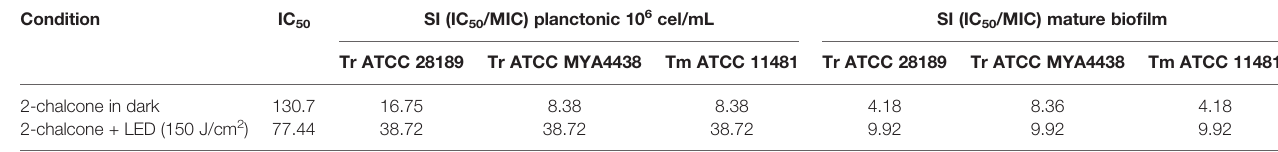
TABLE 2 | Values of IC 50 and selectivity index (SI) in HaCat cell monolayers treated with 2-chalcone in the dark and with photosensitization. Condition IC 50 SI (IC 50 /MIC) mature bio fi lm Tr ATCC 28189 Tr ATCC MYA4438 Tm ATCC 11481 Tr ATCC 28189 Tr ATCC MYA4438 Tm ATCC 11481 2-chalcone in dark